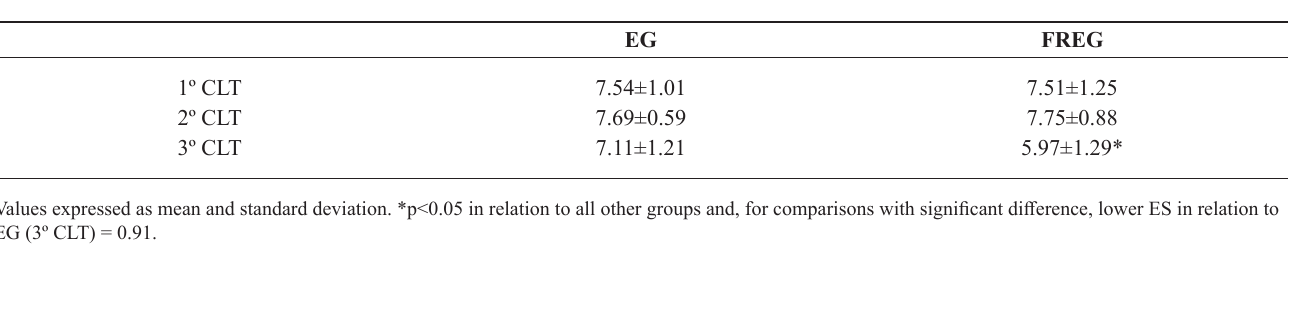
Table 1 - Three critical load tests (CLT) applied to determine critical load intensity (%body mass) in exercised (EG) and food restriction/exercised (FREG) female rats.